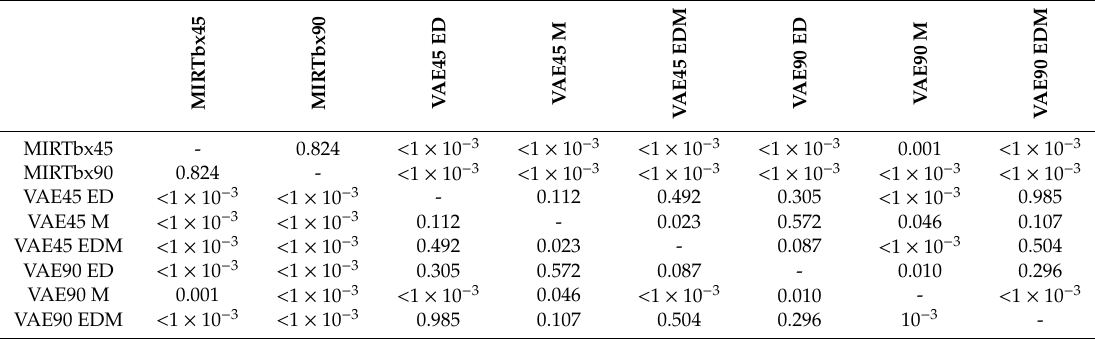
Table 6. Matrix of p -values obtained for Dunn’s post hoc test associated with the k - NN algorithm.